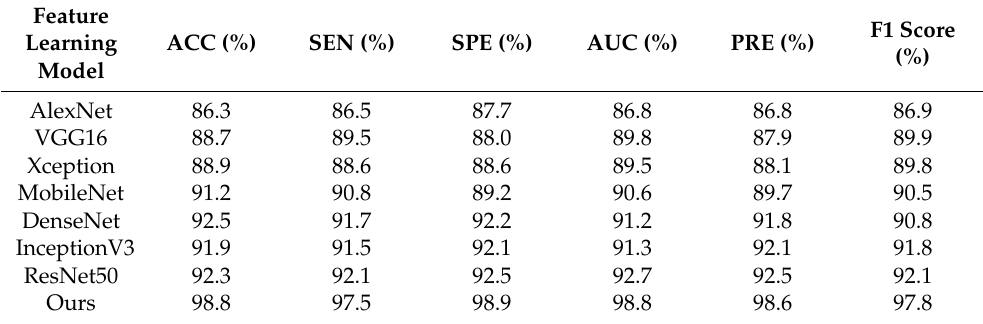
Table 6. Comparison of our proposed model with famous pre-trained feature extraction models for